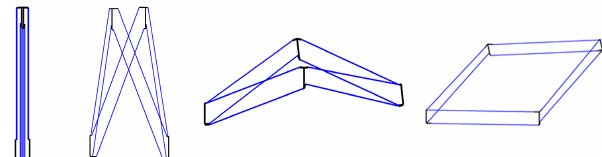
Figure 15. Relative positions of the basic loop mechanism 2 during deployment process.